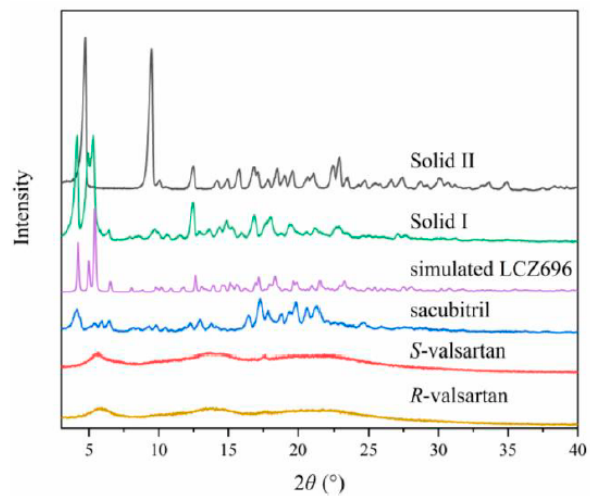
Figure 5. The measured XRPD patterns of S -valsartan, R -valsartan, sacubitril, Solid I, Solid II and the simulated XRPD pattern of LCZ696.